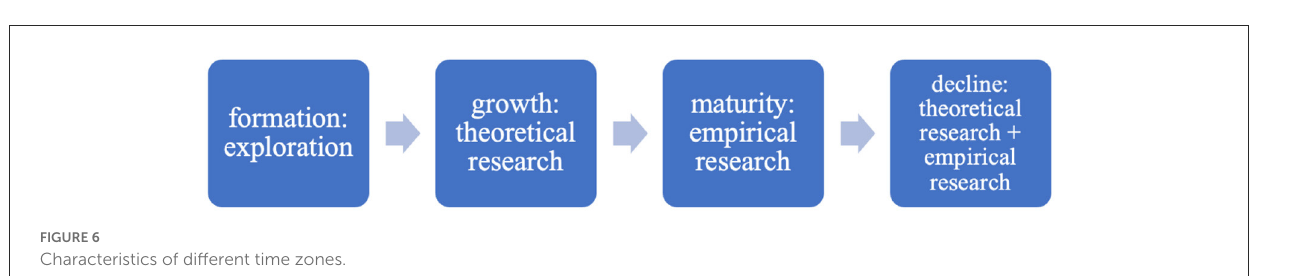
FIGURE5 Time zone view on feminist translation research in China (2002–2021).